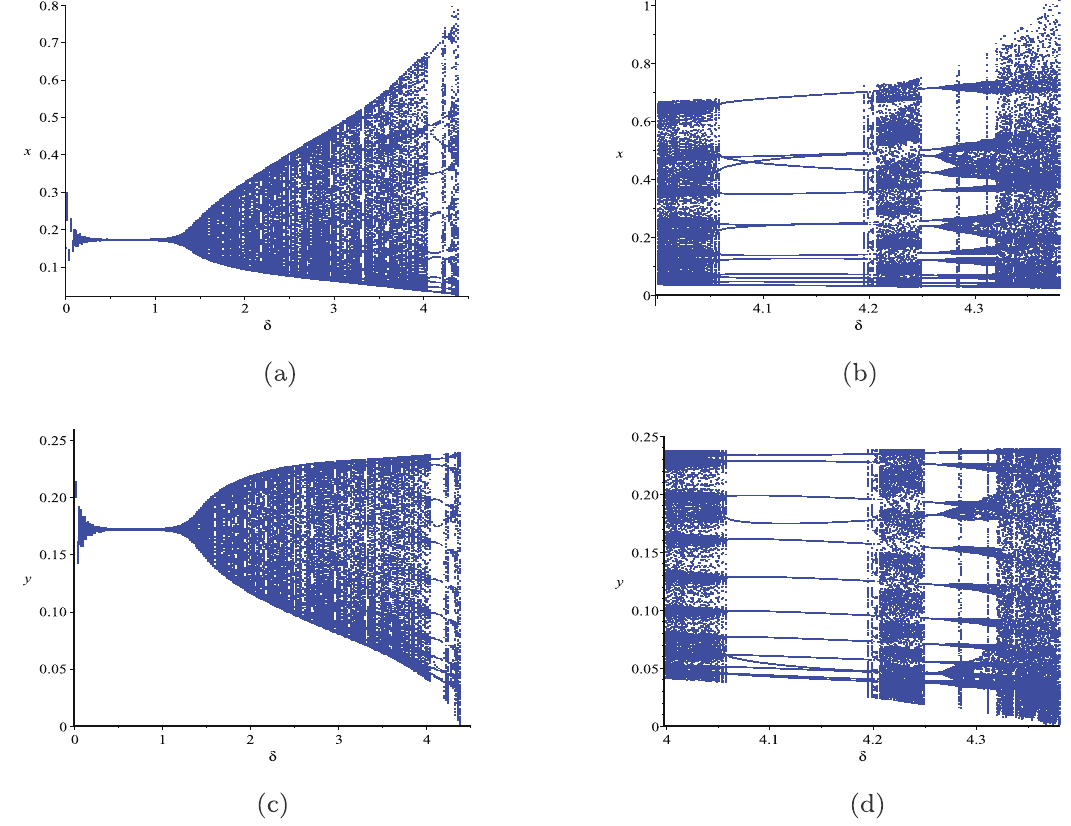
Figure 5: Neimark - Sacker bifurcation of ( 1.3 ) at E 2 ∗ , where the values of parameters are give in ( 4.3 ) , and the initial value is ( ) 0.15, 0.1 . Note that the local ampli fi cations are for [ ] δ 4, 4.38 ∈ . ( a ) In δ x , plane, ( b ) local ampli fi cation of ( a ) , ( c ) in ( ) δ y , plane, and ( d ) local ampli fi cation of ( c )